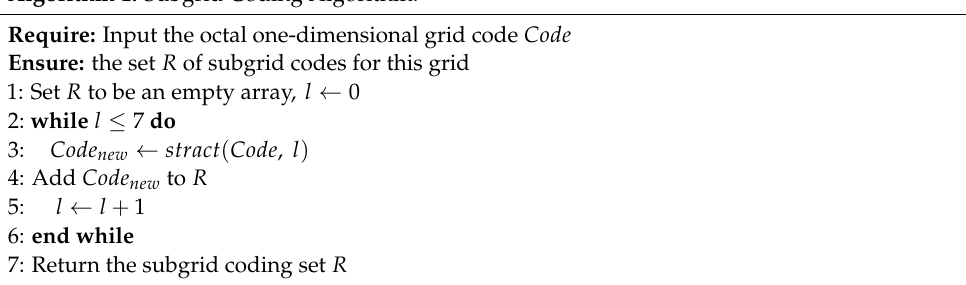
Algorithm 1: Subgrid Coding